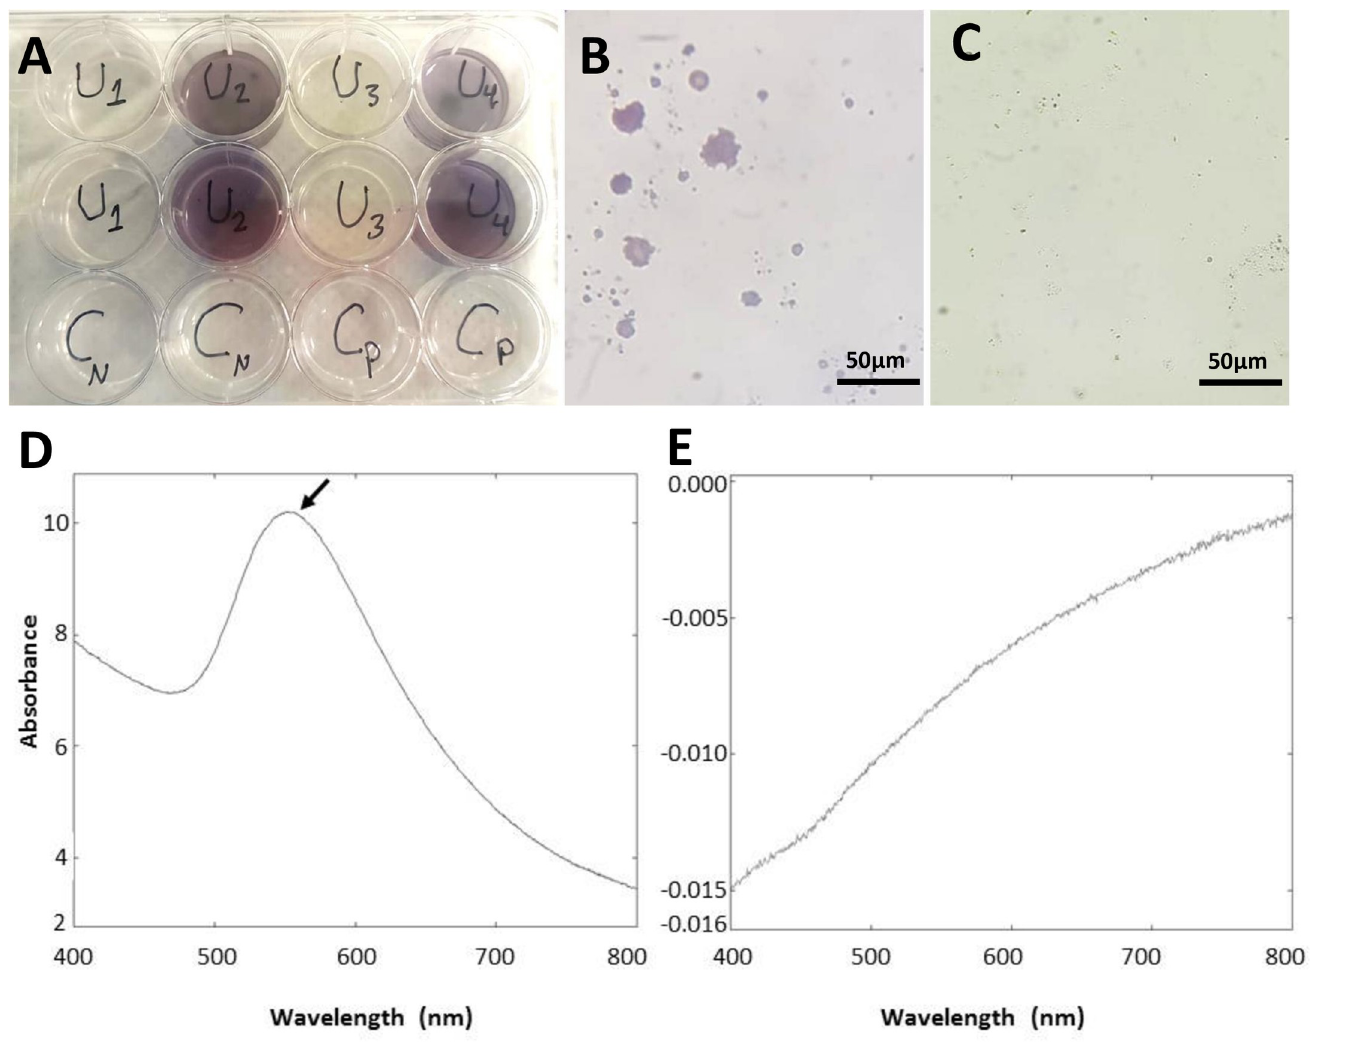
Fig 3. Biogenic synthesis of AuNPs and identification using UV-Vis spectroscopy. (A) Synthesis of AuNPs from mammalian cells metabolites (F180:U2 for AuNP1 and MCF7:U4 for AuNP2) versus AuNPs developed from metabolites extracted from cell-free supernatant (U1 for AuNP3 and U3 for AuNP4) and controls (Gold chloride in PBS: Cn and cells metabolites without Gold chloride: Cp). Gold chloride was incubated with metabolites extracts for 4–6 days at 37˚C in 12-well plates until the development of purple color. (B and C) Light microscopy of (B) AuNPs aggregates (AuNP2) versus (C) control showed no NPs. Scale bar = 50 μ m. (D and E) UV-visible spectra of (D) synthesized AuNPs (AuNP2) versus (E) control. AuNPs showed a peak at λ max 550nm.